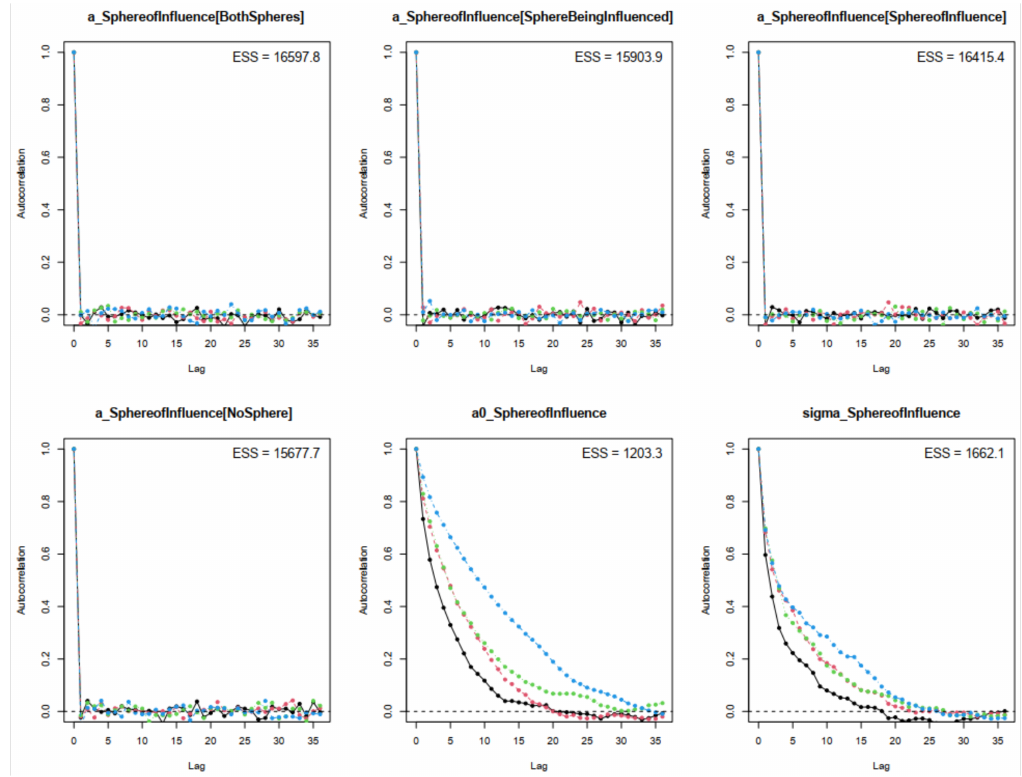
Figure A9. Model 3 (cid:48) s autocorrelation